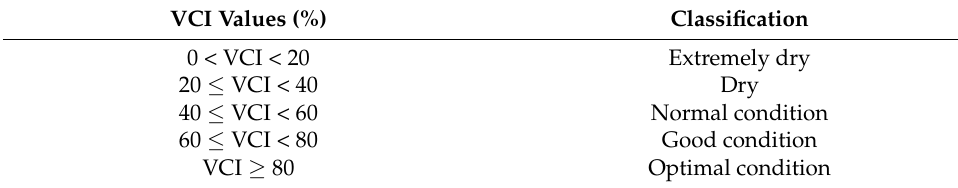
Table 4. Class ranges of the VCI values and their corresponding classifications. VCI Values